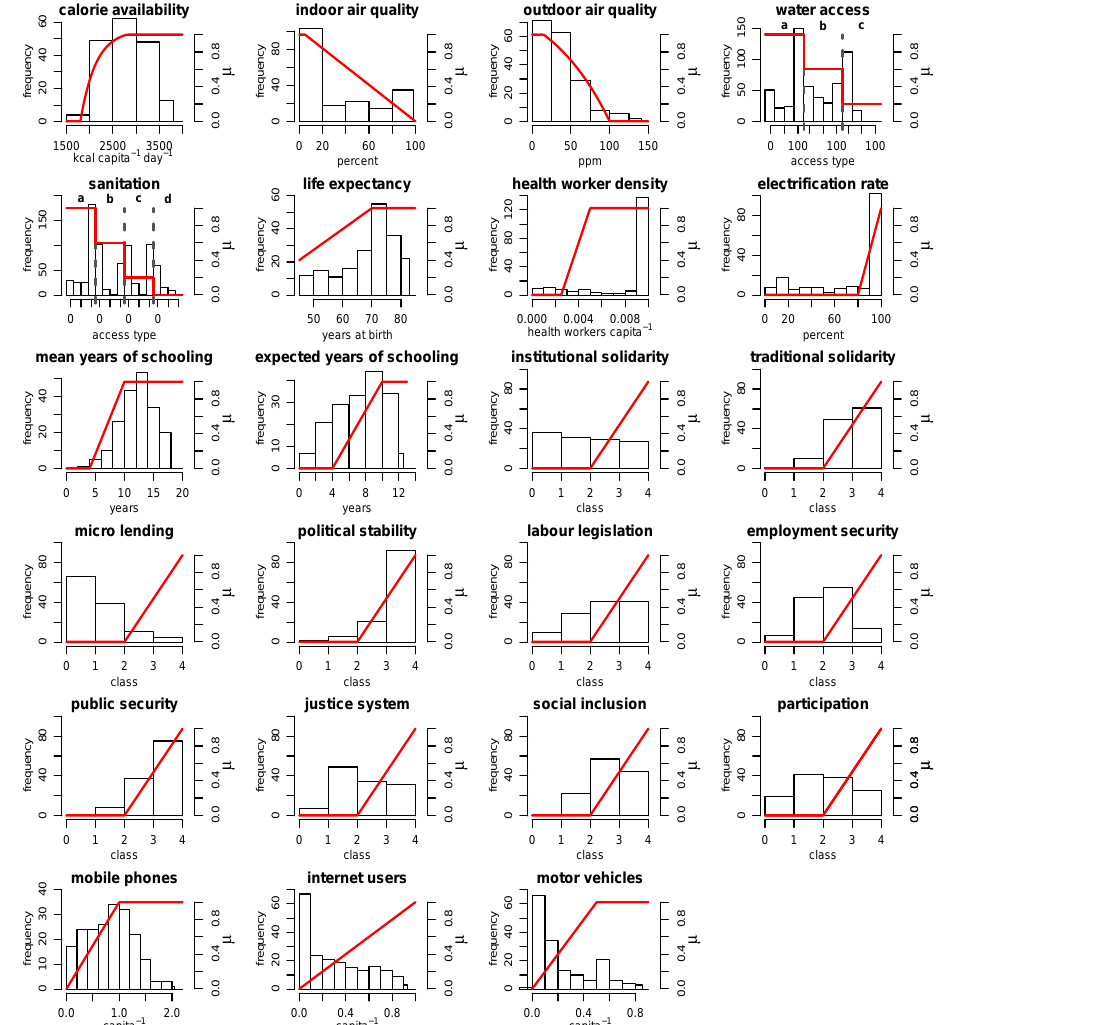
Figure A1. Frequency distributions of the original input data and the membership functions used for their fuzzification. For variable “water access”: (a) piped on premises, (b) other improved access and (c) unimproved access. For variable “sanitation”: (a) improved sanitation, (b) shared facilities, (c) other unimproved and (d) open defecation.